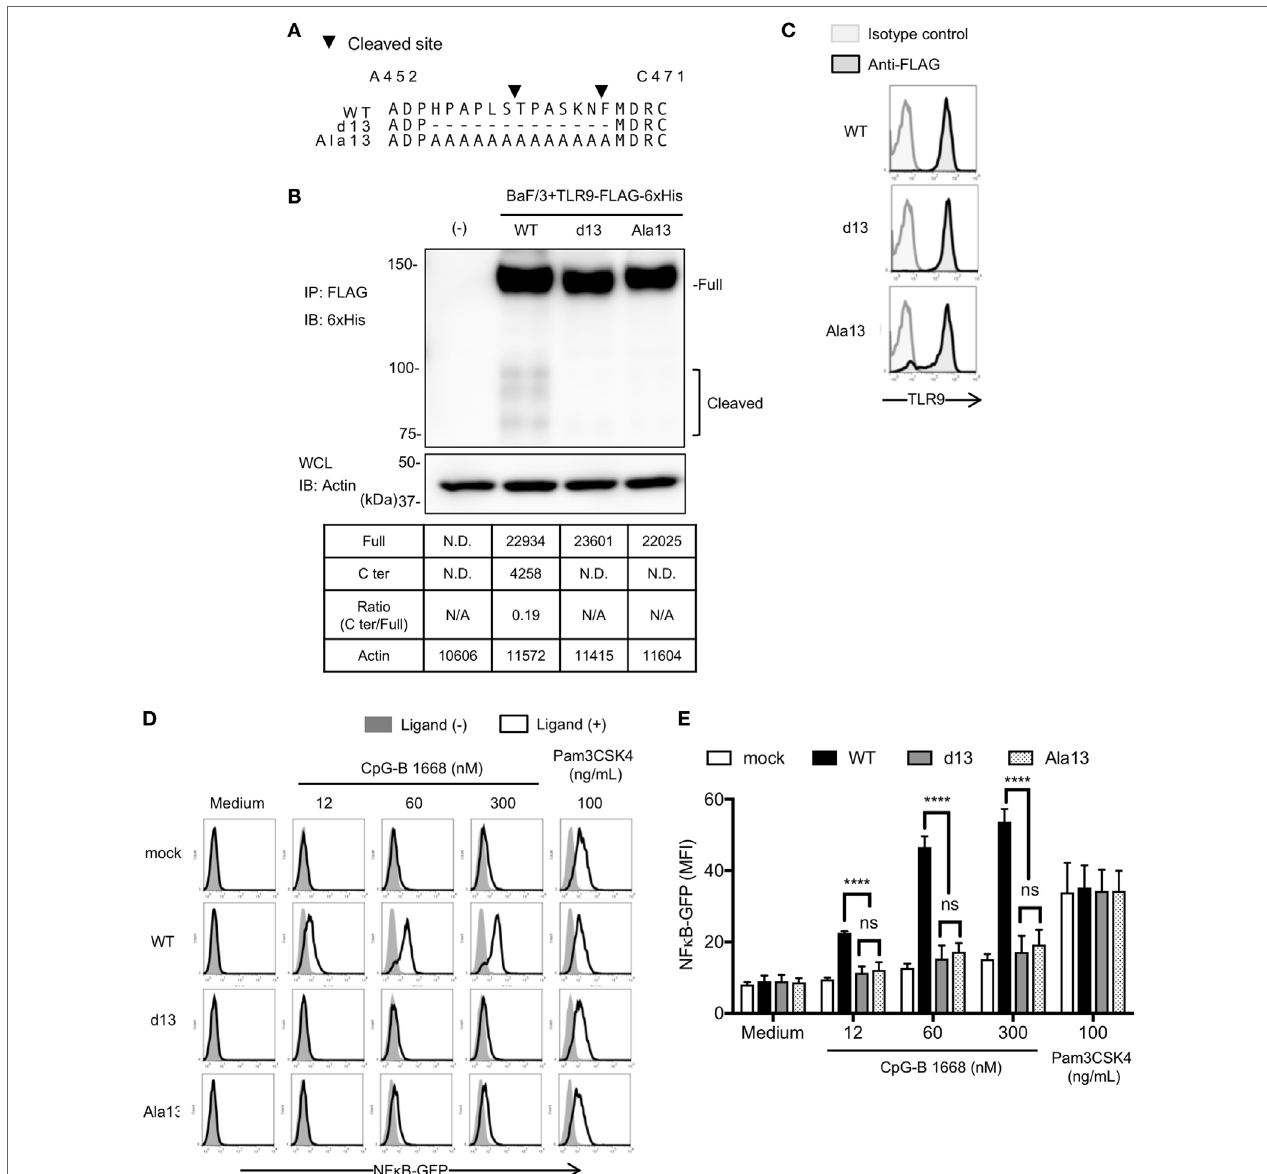
FigUre 4 | Cleavage of toll-like receptor 9 (TLR9) is dependent on the amino acid sequence around the cleavage sites. (a) Amino acid sequence of WT, d13, or Ala13 TLR9. Triangles in the figure indicate the cleaved sites. (B) Cleavage pattern of TLR9 with mutation in the cleavage site. FLAG-6xHis tagged-WT or mutant TLR9s were expressed in Ba/F3 cells. FLAG tag was precipitated and C-terminal region of TLR9 was detected by anti-6xHis. β -actin in whole cell lysate (WCL) was detected as an internal control. The intensity of the bands was quantified and shown in the table. (c–e) Response of TLR9s in Ba/F3 cells. FLAG-6xHis tagged-WT or mutant TLR9s were expressed in Ba/F3 cells harboring nuclear factor kappa B (NF- κ B)-GFP reporter gene. Expression of TLR9s was detected by flow cytometry (c) . Cells were stimulated by TLR9 or TLR2 ligand and activation of NF- κ B was monitored as GFP expression by flow cytometry after 24 h incubation (D) . Mean fluorescent intensity of NF- κ B-GFP was indicated as graph. Cells were stimulated in triplicated wells and the mean SD is shown (e) . At least three times of experiments were performed independently (B–e) . Data were statistically analyzed by two-way ANOVA with multiple comparisons (D,e) . **** p < 0.0001. Abbreviations: ns, not significant; ND, not detected; N/A, not